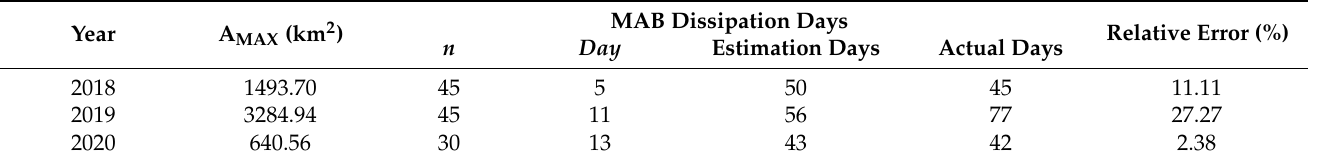
Table 2. Comparison of the estimation of dissipation days and the actual number of days from 2018 to 2020. Year A MAX (km 2